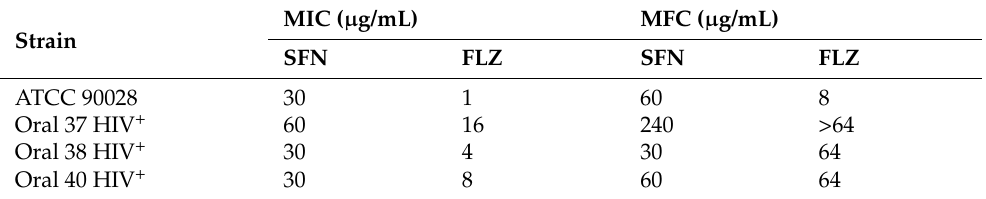
Table 3. Minimum Inhibitory Concentration (MIC; µ g/mL) and Minimum Fungicidal Concentration (MFC; µ g/mL) values of sulforaphane (SFN) compared to fluconazole (FLZ) against C. albicans ATCC 90028 and C. albicans clinical isolates (Oral 37 HIV + , Oral 38 HIV + , and Oral 40 HIV + ). MIC ( µ g/mL) MFC ( µ g/mL) Strain